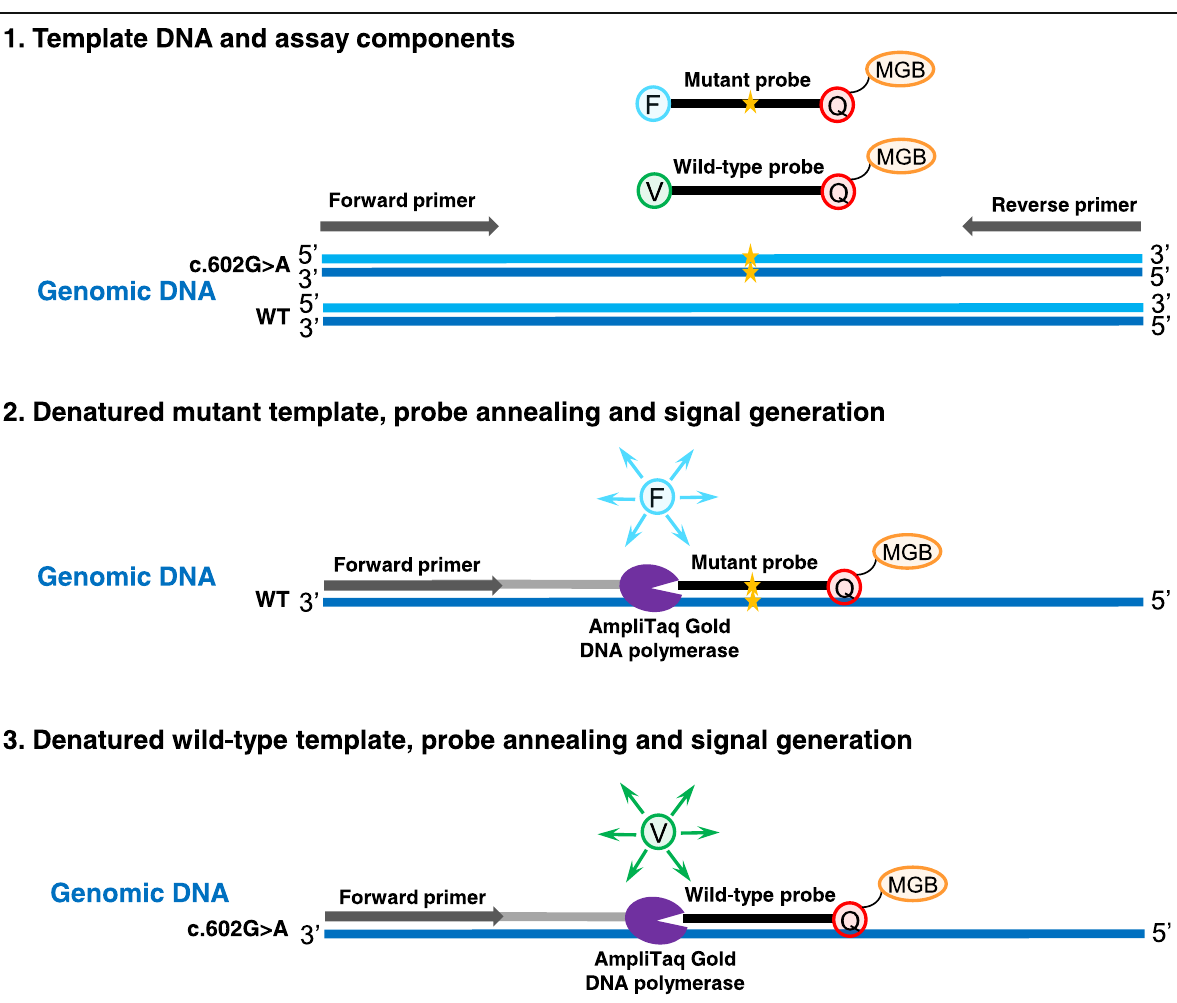
Fig. 2 Schematic overview of the Taqman assay. In addition to the genomic DNA template, four additional oligonucleotide components are required to detect the mutation. These include an unlabeled PCR primer pair and two TaqMan probes with a FAM (F) or a VIC (V) dye label on the 5 ’ end, in combination with a minor groove binder (MGB) and a nonfluorescent quencher (Q) on the 3 ’ end (1). The TaqMan probes hybridize to the target DNA after denaturation between the unlabeled PCR primers. The signal from the fluorescent dye on the 5 ’ end of a TaqMan probe is quenched by the quencher on its 3 ’ end through fluorescence resonance energy transfer (FRET) (2). During PCR, the AmpliTaq Gold DNA polymerase extends the unlabeled primers using the genomic DNA template strand. When the DNA polymerase reaches the TaqMan probe, it cleaves the molecule, separating the fluorescent dye from the quencher. The qPCR instrument detects fluorescence from the unquenched FAM or VIC dye in one reaction